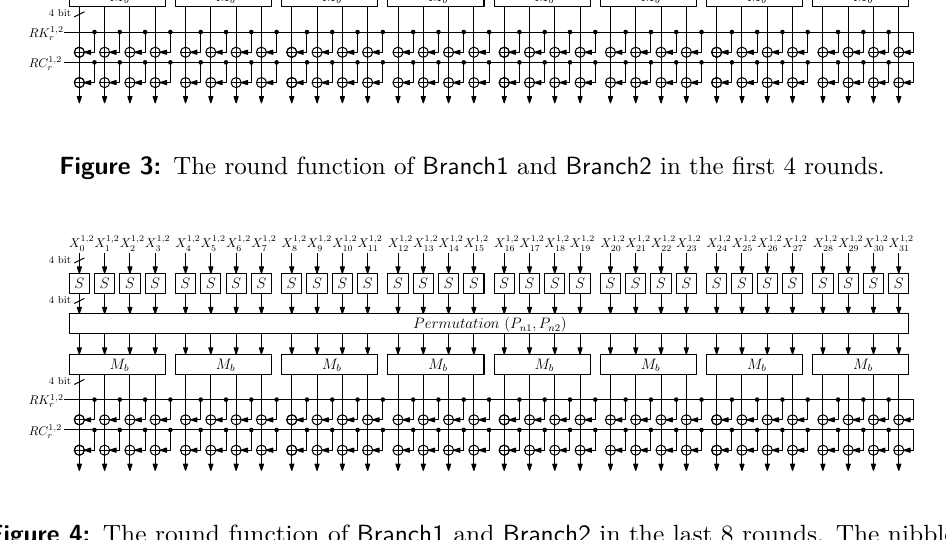
Figure 4: The round function of Branch1 and Branch2 in the last 8 rounds. The nibble permutation and the matrix multiplication in the last round will be